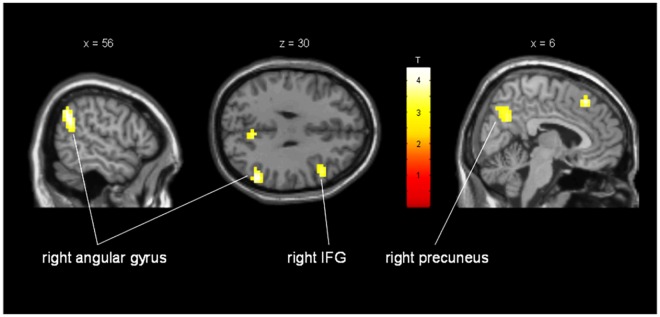
Increased activation of ALS patients compared to healthy controls when processing different emotional facial expressions.Activation in a sub region of the right inferior frontal gyrus (MNI coordinates: x = 49mm y = 18mm z = 30mm; cluster size = 37 voxels; T = 3.53; puncorr = 0.001), right angular gyrus (MNI coordinates: x = 56mm y = -58mm z = 34mm; cluster size = 102 voxels; T = 4.40; puncorr<0.001) and right precuneus (MNI coordinates: x = 6mm y = -62mm z = 34mm; cluster size = 31 voxels; T = 3.42; puncorr = 0.001). Activations show areas with significant increase of activity in patients in average for all emotions.